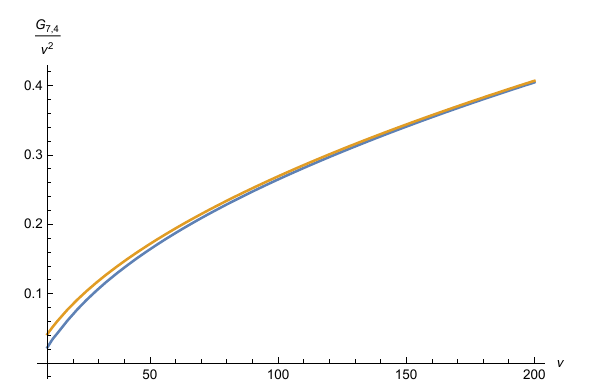
in the 2d Ising model. We plot the di(cid:11)erence 1 7 ; 4